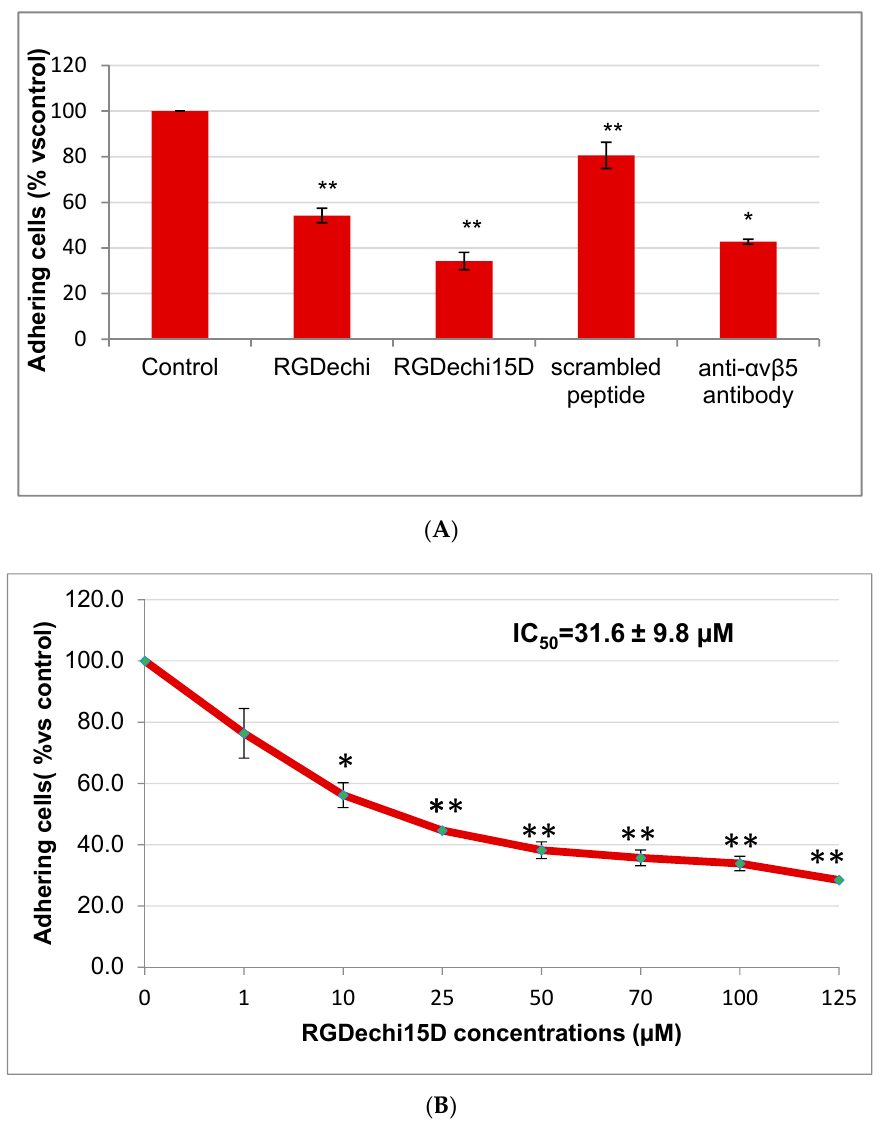
Figure 2. Inhibition of cell adhesion on vitronectin coated plates. ( A ) HepG2 cells were pre-incubated with peptides (50 µM) or anti- α v β 5 antibody (10 µg/mL) or ( B ) with increasing concentrations of RGDechi15D, for 30 min at 4 °C and then seeded on vitronectin coated plates at 37 °C. Cell adhesion was evaluated after 1 h of incubation using crystal violet reagent. Results are presented as the percentage of adherent cells with respect to the control (untreated cells) and are expressed as means ± standard error (SE) of at least three independent experiments performed in triplicate. Statistical significance was analyzed using Student’s t test, unpaired, two-sided (** p < 0.01, * p < 0.05).